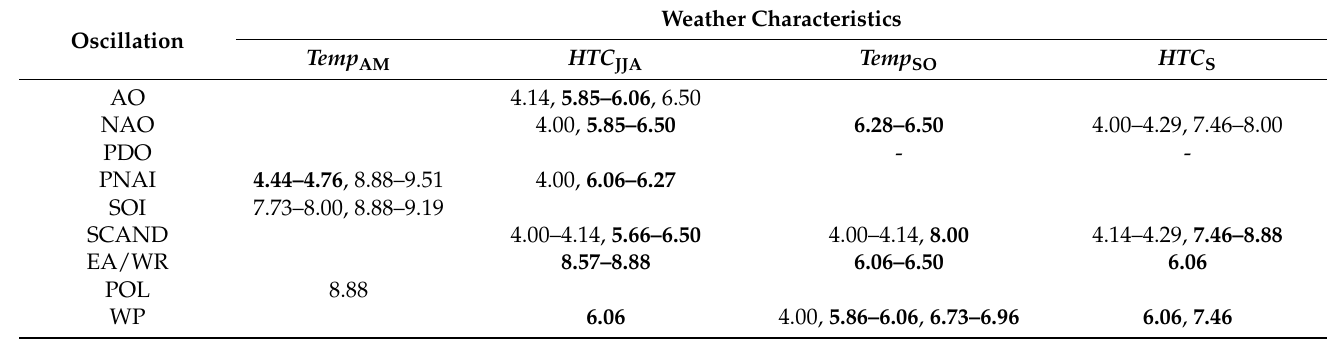
Table 3. Coherence between climate oscillations and weather conditions–predictors of the pine looper outbreaks. The given periods (4 ≤ period ≤ 10) had the statistical significance of the average wavelet coherence ≤ 0.1. “-” indicates no such periods. Periods intersecting with the range in which the coherence between outbreaks and oscillation was statistically significant at p = 0.1 level are shown in bold. If we performed no analysis for “oscillation–weather characteristic” pair (the coherence with the outbreak was weak), the cell remains